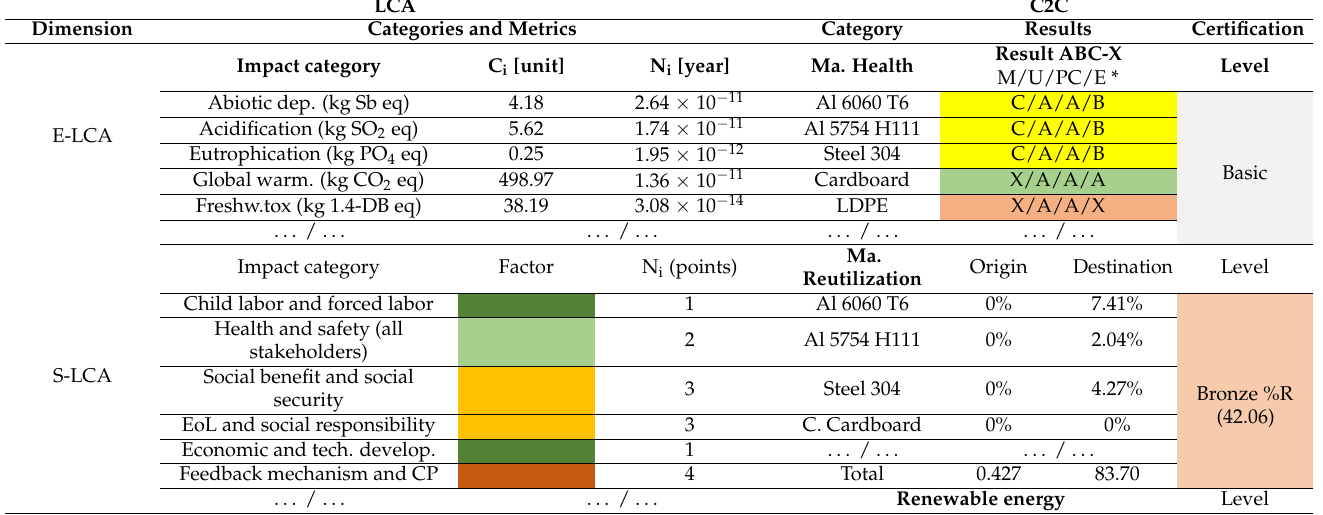
Table 4. Results of micro